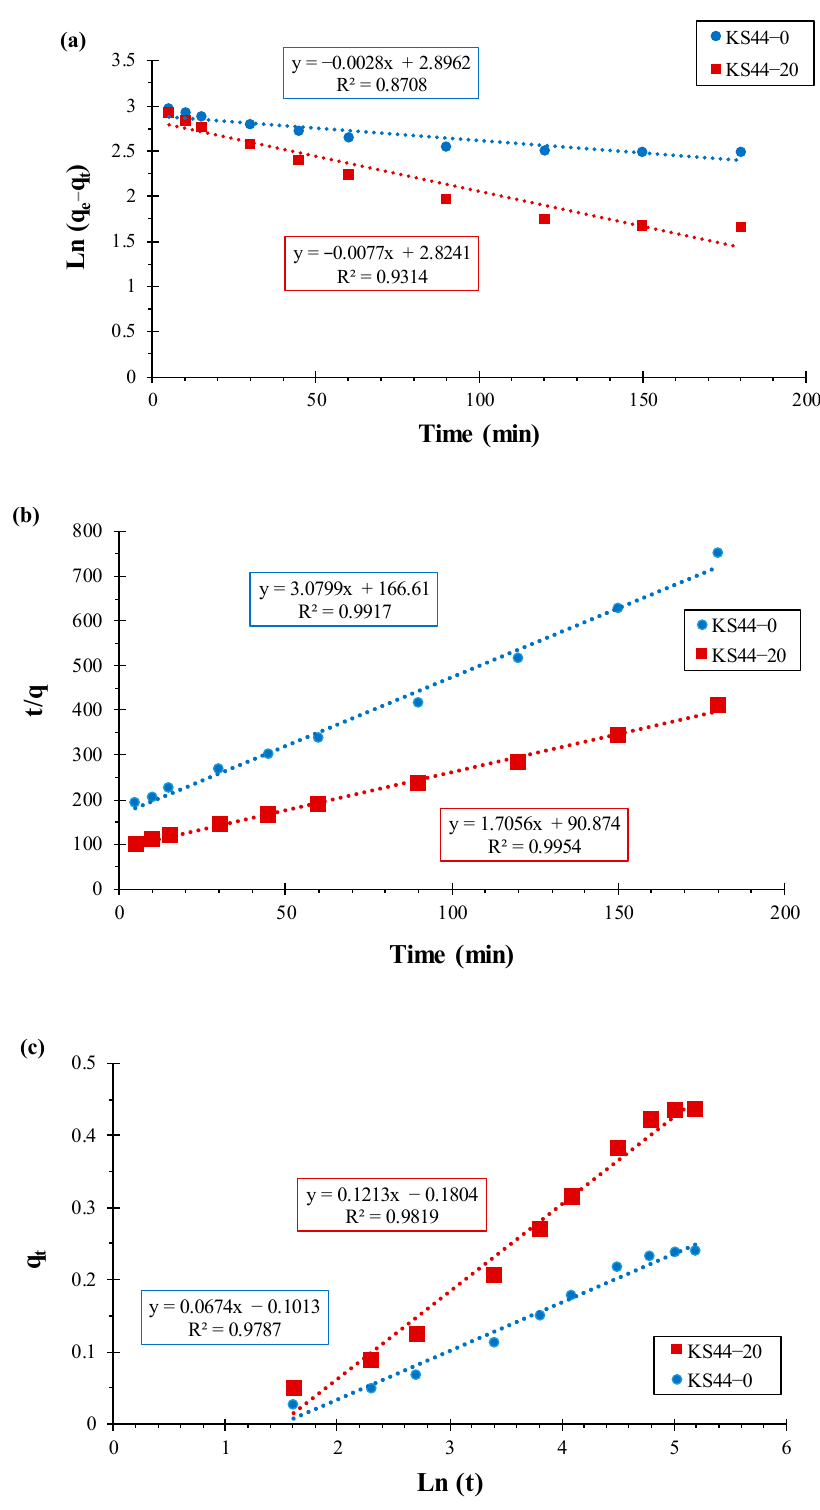
Figure 4. Kinetic parameters of the pseudo-first-order ( a ), pseudo-second-order ( b ) and the Elovich model ( c ) for RhB adsorption on KS44-0 and